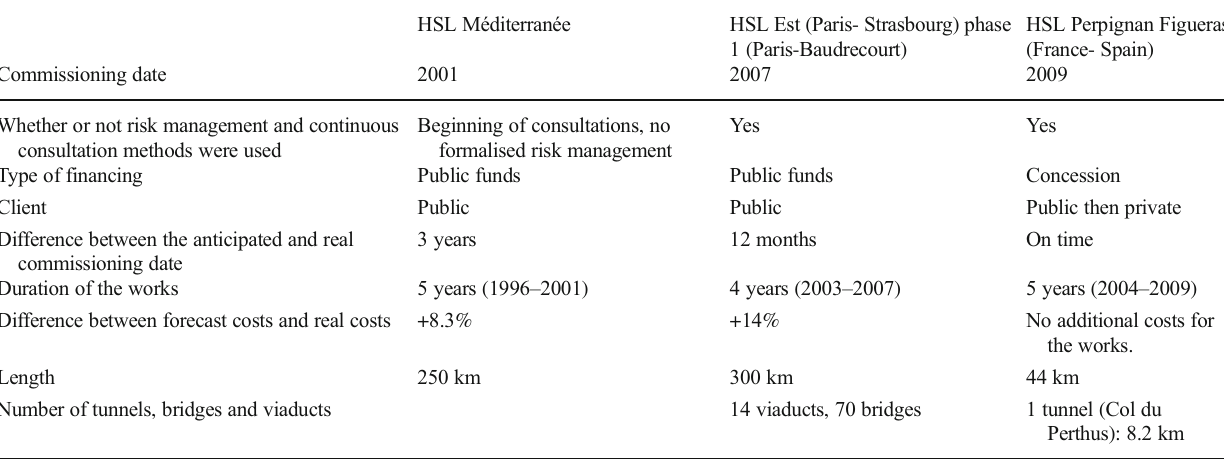
Comparison between three HSL projects (anticipated and real commissioning dates, anticipated and real costs) HSL